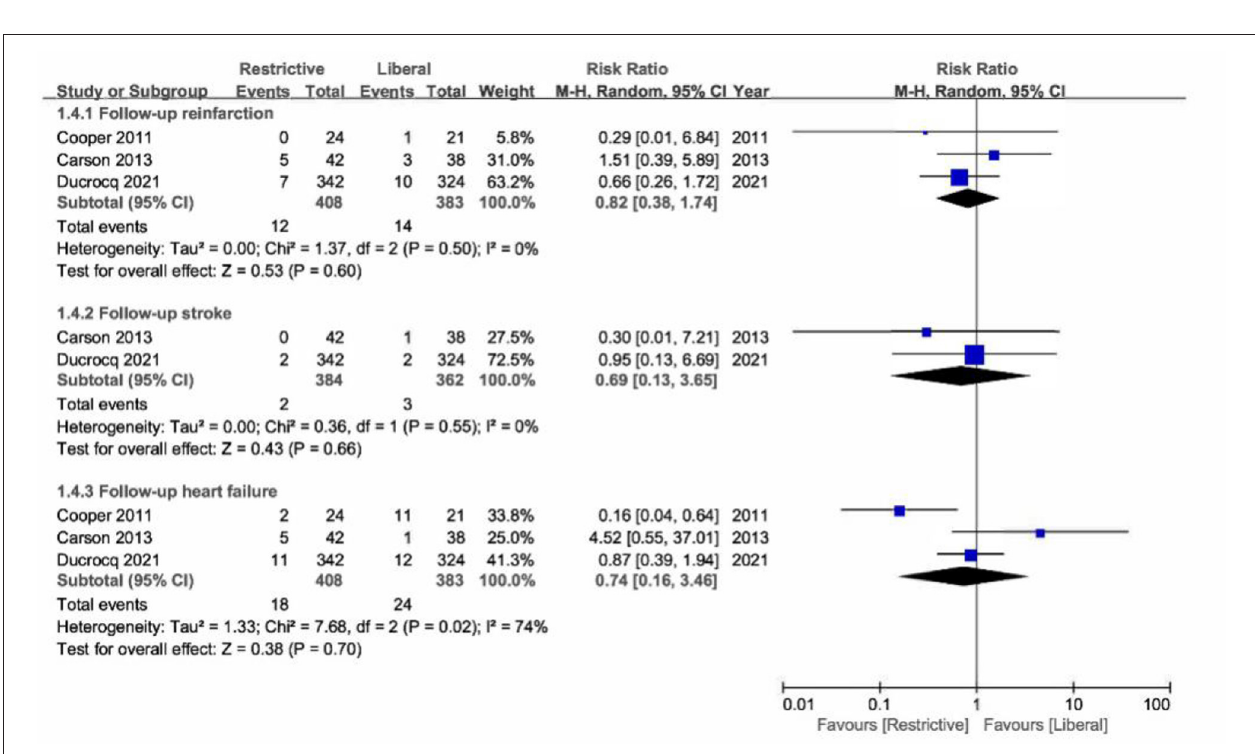
FIGURE 2 | Forest plot for the association between blood transfusion strategies with overall mortality.